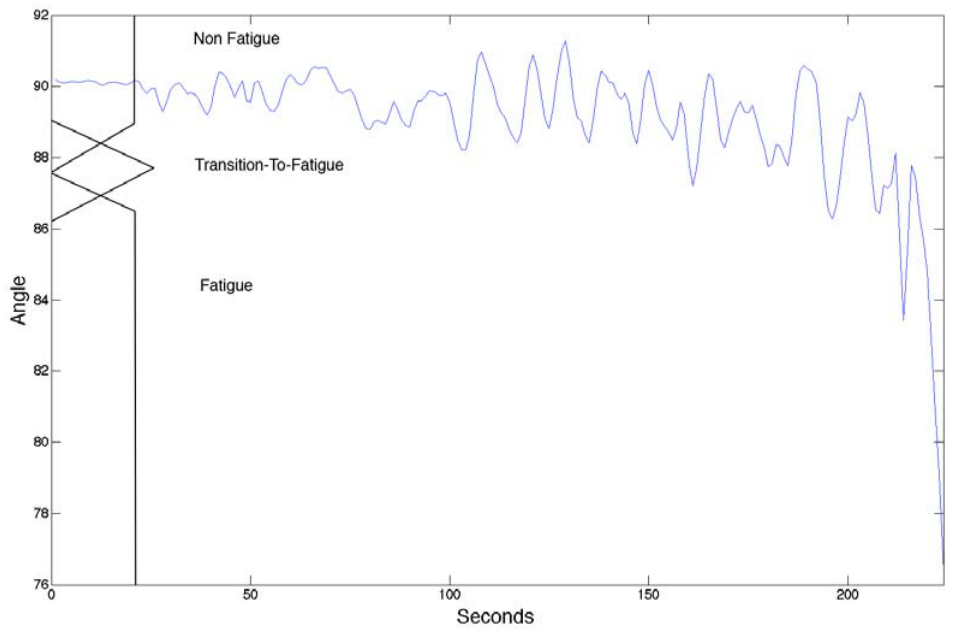
Figure 1. The fuzzy set input for the angular position of the